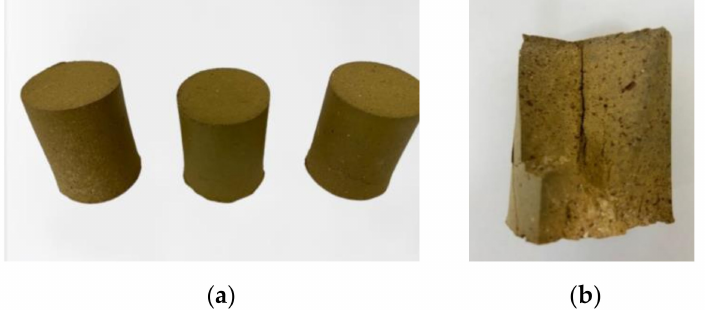
Figure 1. Samples with the addition of 0.315–0.16 mm diatomite fraction after burning at 1150 ◦